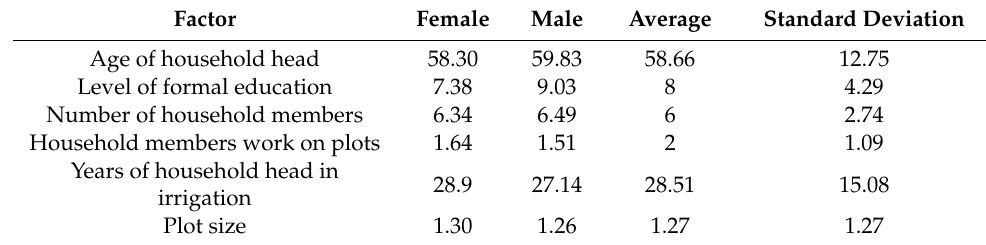
Table 1. Household characteristics.